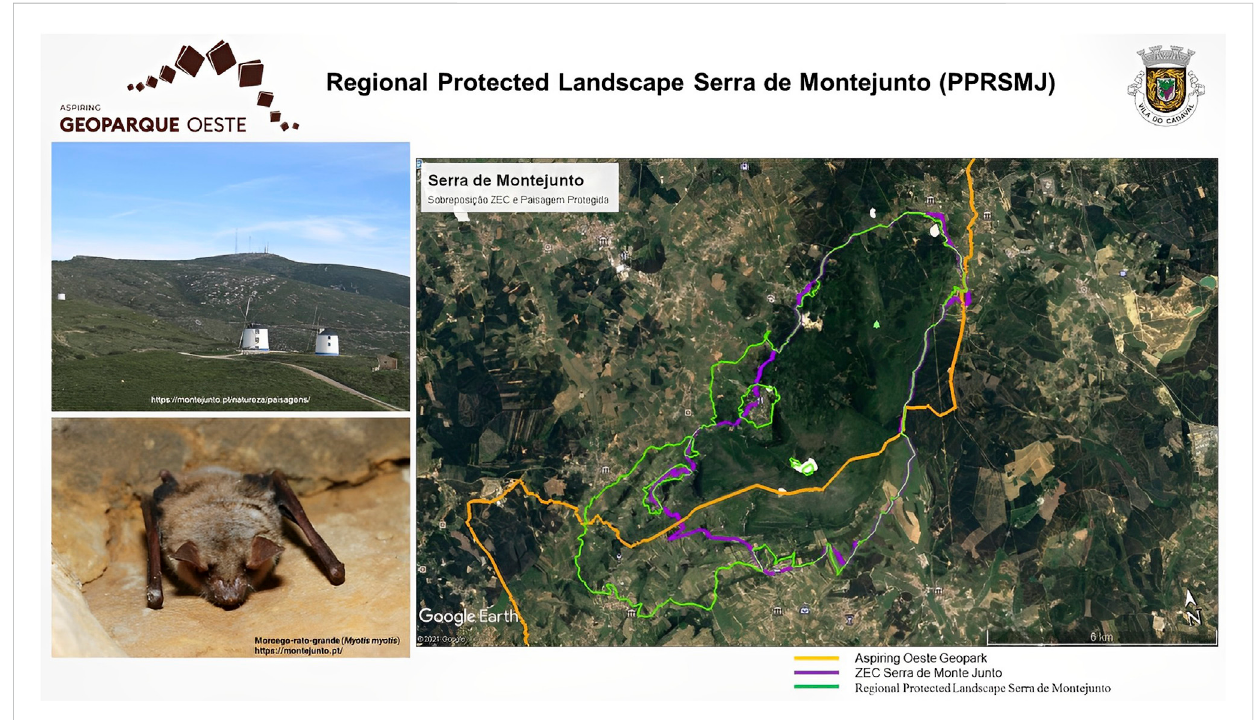
FIGURE 8 Serra de Montejunto regional protected landscape. Source: produced by the authors.